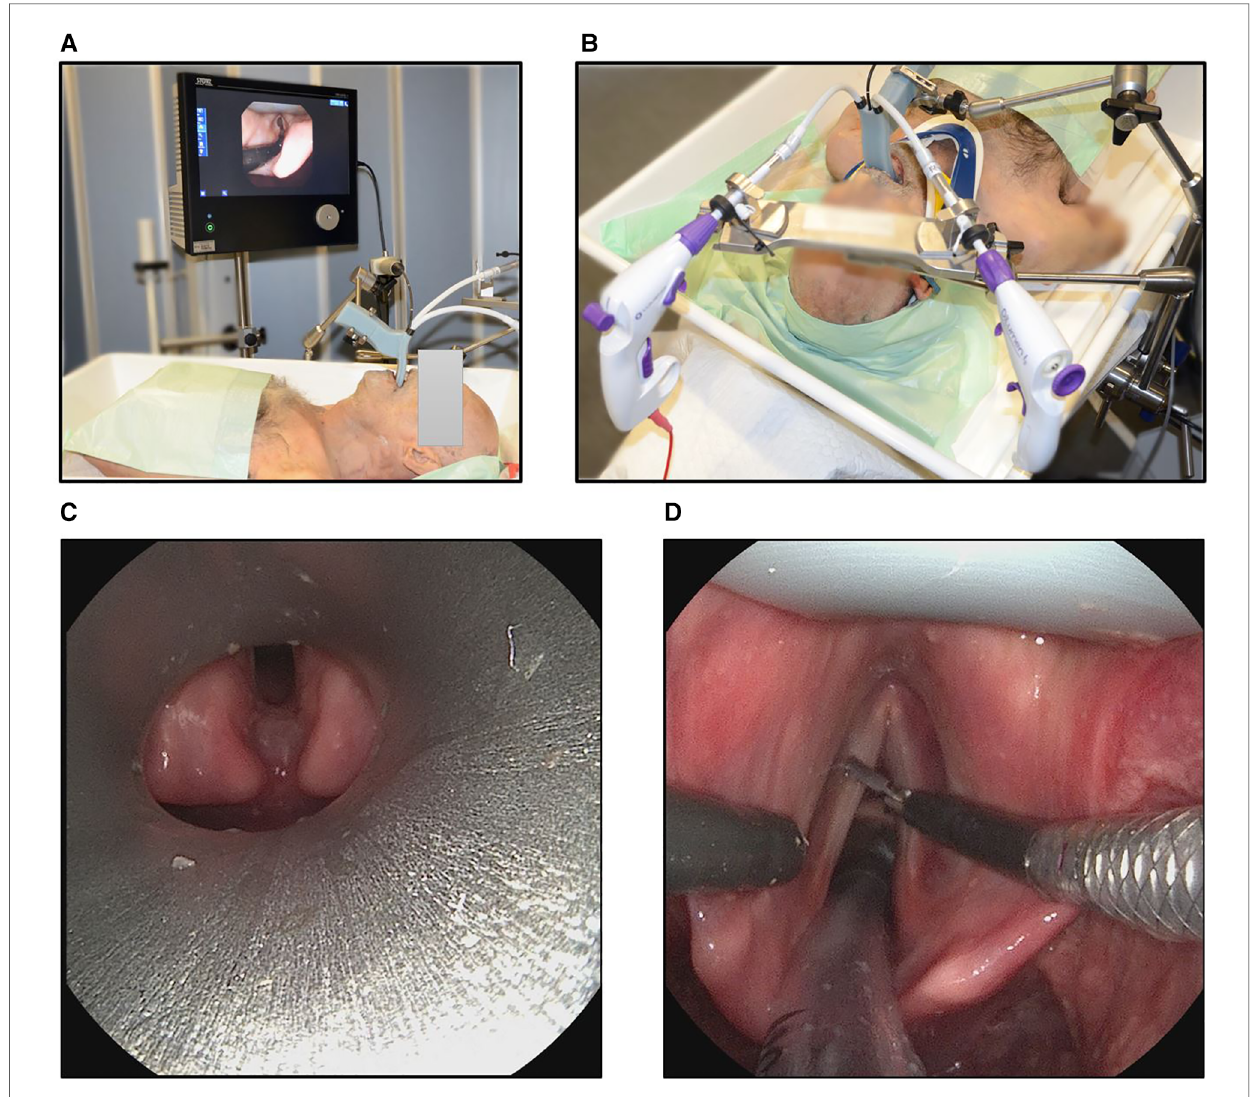
FIGURE 4 Experimental setup of the sMAC on a human body donor torso. The sMAC laryngoscope was attached to the operating table using a clamping jaw and an articulated stand. The image of the fl exible video endoscope was displayed on an 18.5-inch Monitor as in the user study. ( A ) Mobile and ( B ) immobilized neck via cervical support. ( C ) View of the glottic plane with an conventional operating laryngoscope positioned by an experienced head and neck surgeon and with the neck of the body donor not being immobilized. ( D ) View of the operating fi eld with the sMAC system in a human body donor with immobilized neck. The grasper instrument is on the right side, the monopolar needle instrument on the left side and an endotracheal tube is inserted to the